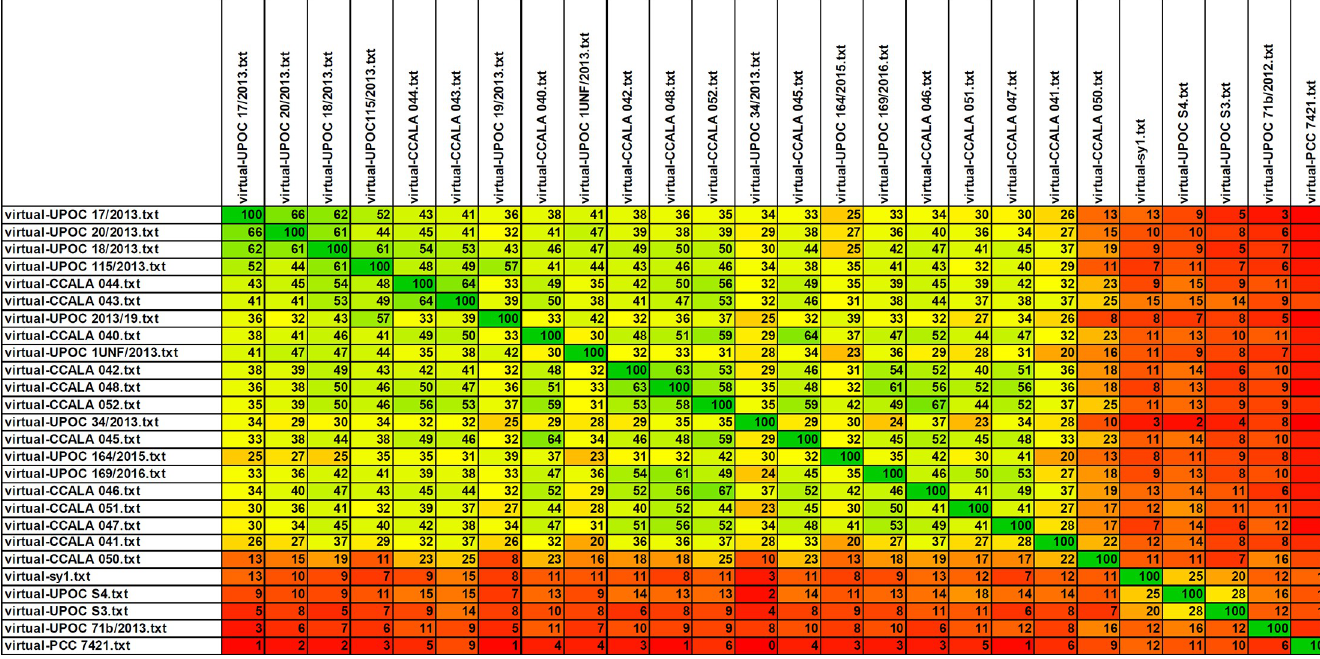
Fig 6. A map of similarities of Chroococcidiopsis species/isolates based on IC MALDI mass spectra. Multiple MALDI-TOF mass spectra acquired with intact cells of Chroococcidiopsis and other studied cyanobacteria were processed in Biospean [18] to generate virtual spectra (representing characteristic line spectra or “barcodes”) for individual samples. Then all virtual spectra were compared with each other to calculate percentage similarity values reflecting the presence of signals with the same m/z value (with a tolerance of ± 2 Da). The increase in the percentage value is displayed as a continuous color change in the order red (0) < dark orange < light orange < yellow (50) < light green < green < dark green (100).